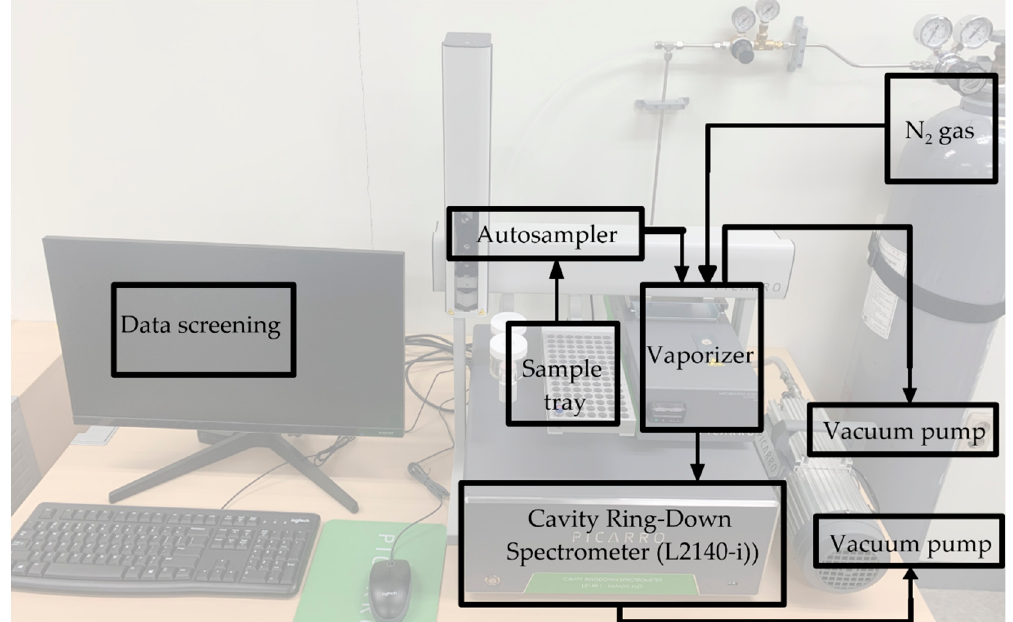
Figure 1. Schematic of the Picarro cavity ring-down spectrometer (L2140- i ) installed at the Environmental Geochemistry Laboratory of Ewha Womans University.